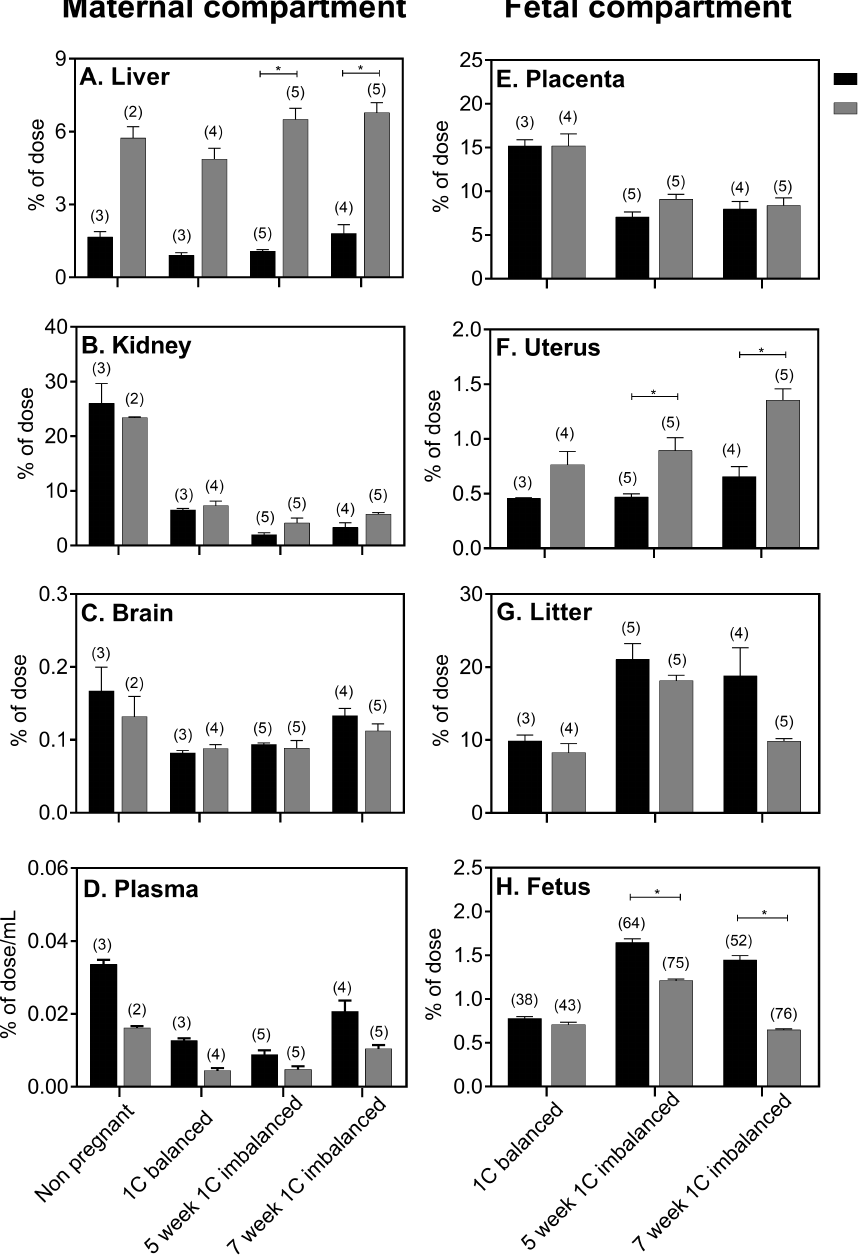
Figure 4. Labeled B12 in maternal tissues and fetuses. Tissue [ 57 Co]B12 accumulation (CN-B12 (CN) or HO-B12 (HO)) in 1C balanced and 1C imbalanced rats at gestation day 20, measured 24 h after oral administration. Depicted are fractions of the administered [ 57 Co]B12 (% of dose) present in selected organs per whole organ and as % of dose/mL plasma. Results are shown as mean with SEM. Number ( n ) of animals in each column is shown in parentheses. Differences between administrations of [ 57 Co]CN-B12 (black) and [ 57 Co]HO-B12 (grey) were estimated with the Mann–Whitney test with Bonferroni corrections (level of significance for maternal compartment (left column, A – D ): p <0.05/4 = 0.01; level of significance for fetal compartment (right column, E – H ), p <0.05/3 = 0.02). * Asterisks denote statistical significance according to the Bonferroni